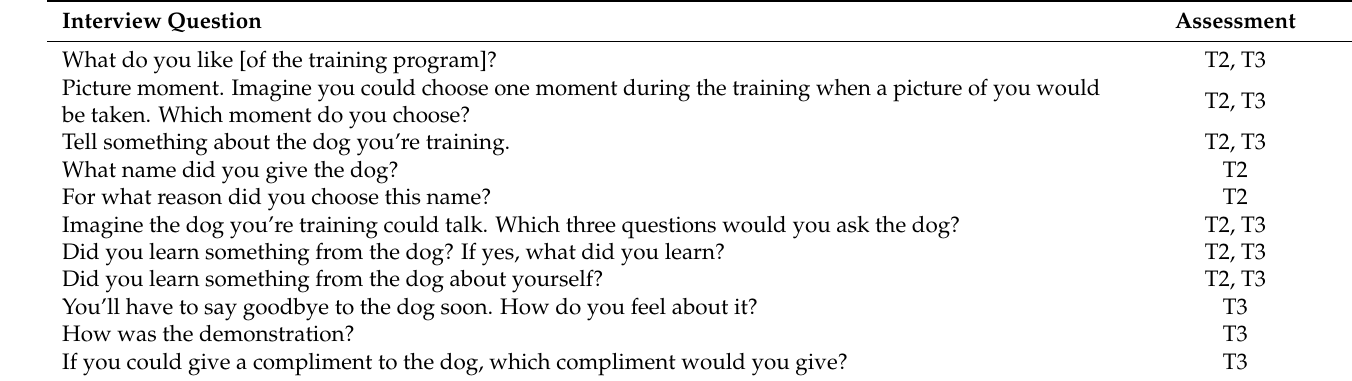
Table A1. Selected Interview Questions reflecting Human–Animal Bond Quality.